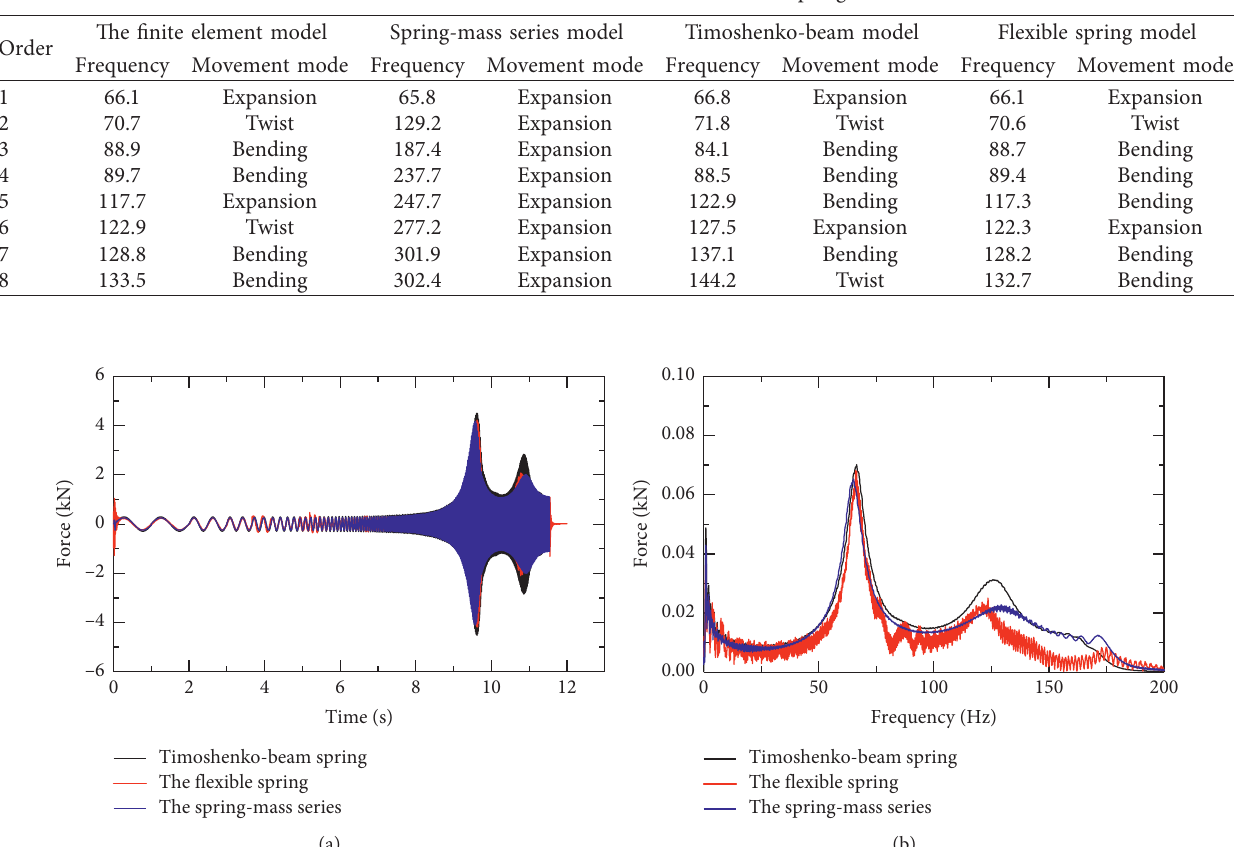
Figure 10: Comparison of reaction forces of three equivalent models. (a) Time domain comparison. (b) Frequency domain comparison.